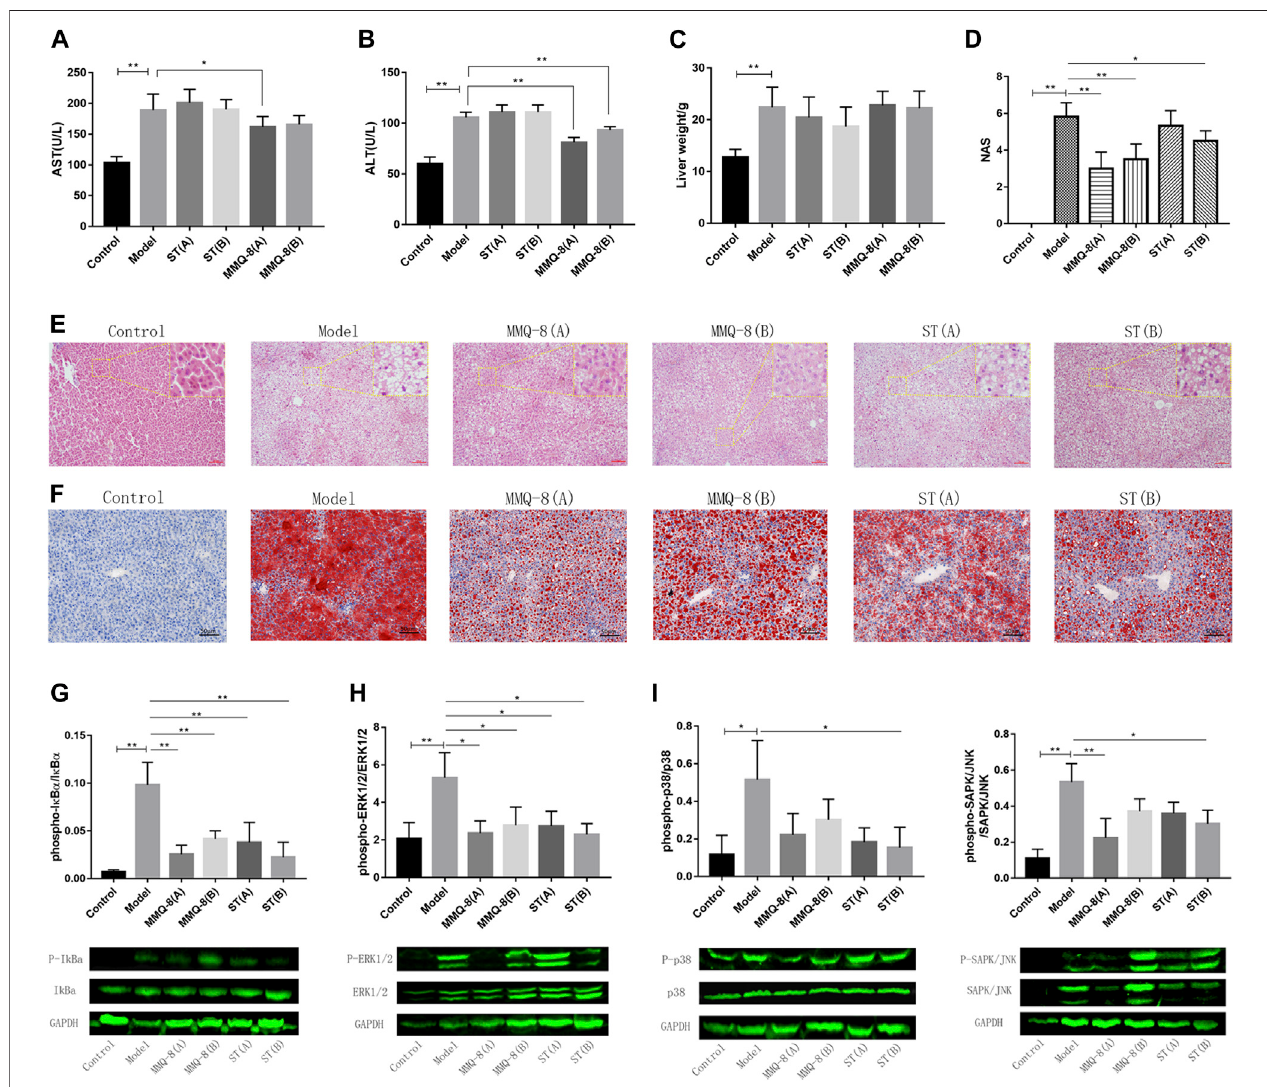
FIGURE4| MMQ-8signi fi cantlyreducedhepaticsteatosisandimprovedliverfunctioninobeseratsfedanHFD. (A) LevelsofserumhepaticfunctionalmarkerAST. (B) Levels of serum hepatic functional marker ALT. Serum hepatic functional markers were reversed by MMQ-8 treatment. This suggested that MMQ was safe and did notcauselivertoxicity. (C) Liverwetweights. (D) NASofliverH&Estainingimages. (E) RepresentativeH&Estainingofliver( n =6). (F) RepresentativeOilredOstainingof liver( n =6).MMQ-8treatment signi fi cantlyreducedhepaticsteatosis. (G) MMQ-8treatmentdecreasedthephosphorylationlevelsofI κ B α inlivertissue (H) MMQ-8 treatment decreased the phosphorylation levels of ERK1/2 in liver tissue. (I) MMQ-8 treatment decreased the phosphorylation levels of p38 in liver tissue. (J) MMQ-8 treatment decreased the phosphorylation levels of SAPK/JNK in liver tissue. MMQ-8 reduced liver protein phosphorylation levels of the TNF signaling pathway in obese rats. Data are presented as means ± SD, n = 8, * p < 0.05, ** p < 0.01.